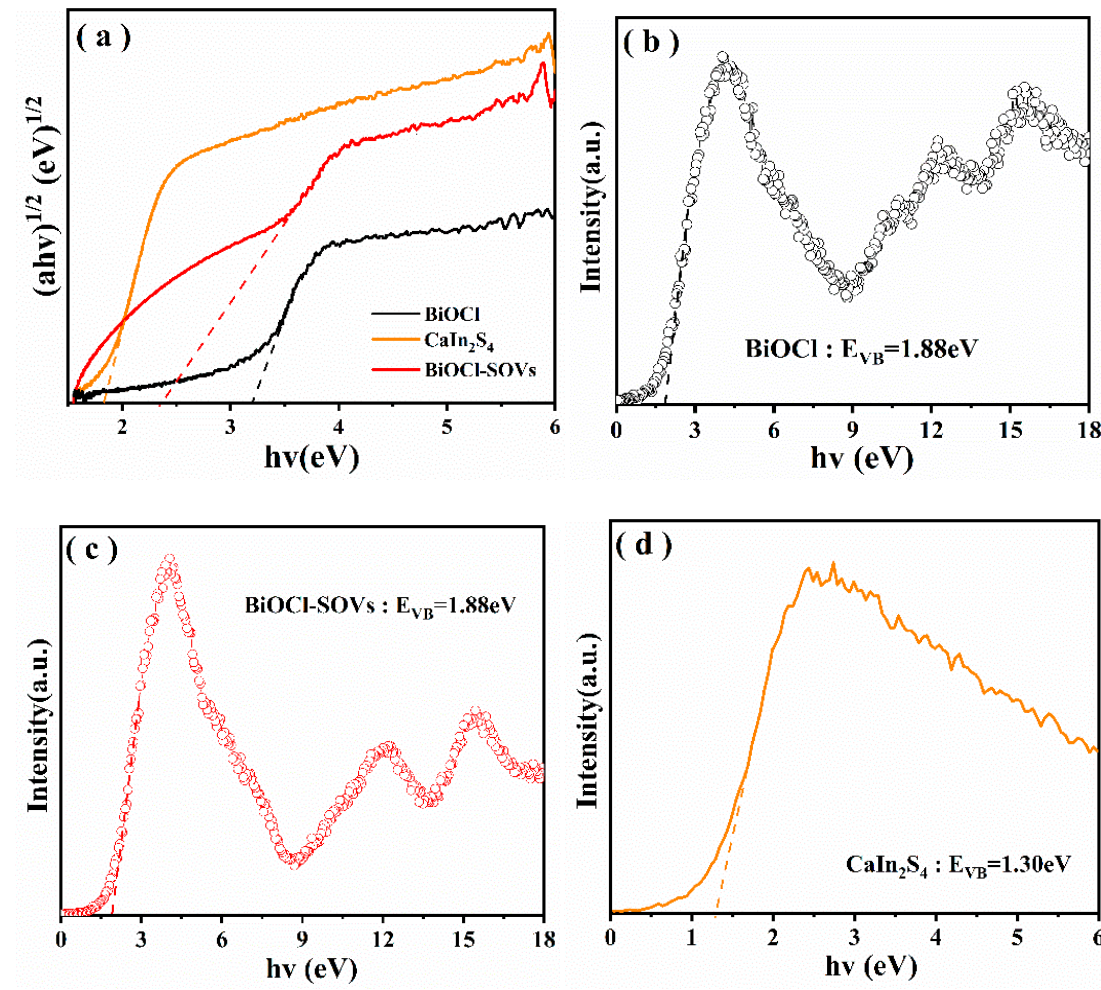
Figure 13. ( a , b ) The corresponding Tauc curves of BiOCl, BOC-SOVs, and CaIn 2 S 4 , and ( c , d ) VB spectra of the BOC-SOVs and CaIn 2 S 4